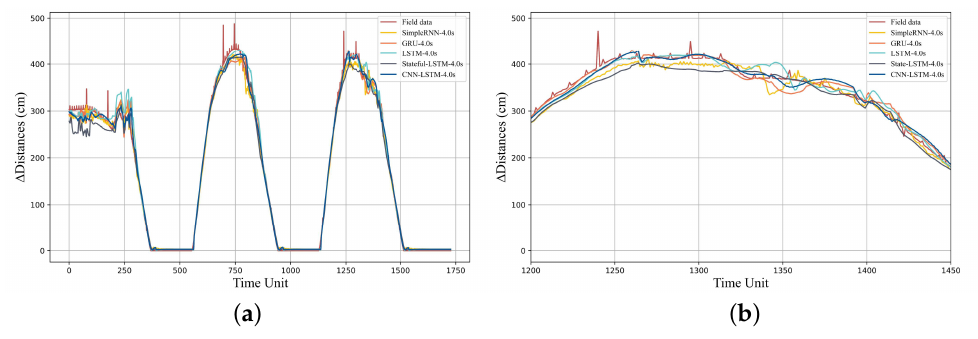
Figure 6. Field data and predicted position. ( a ) Train position curve in the 4.0 s. ( b ) Train position curve between 1200 and 1450 units in the 4.0